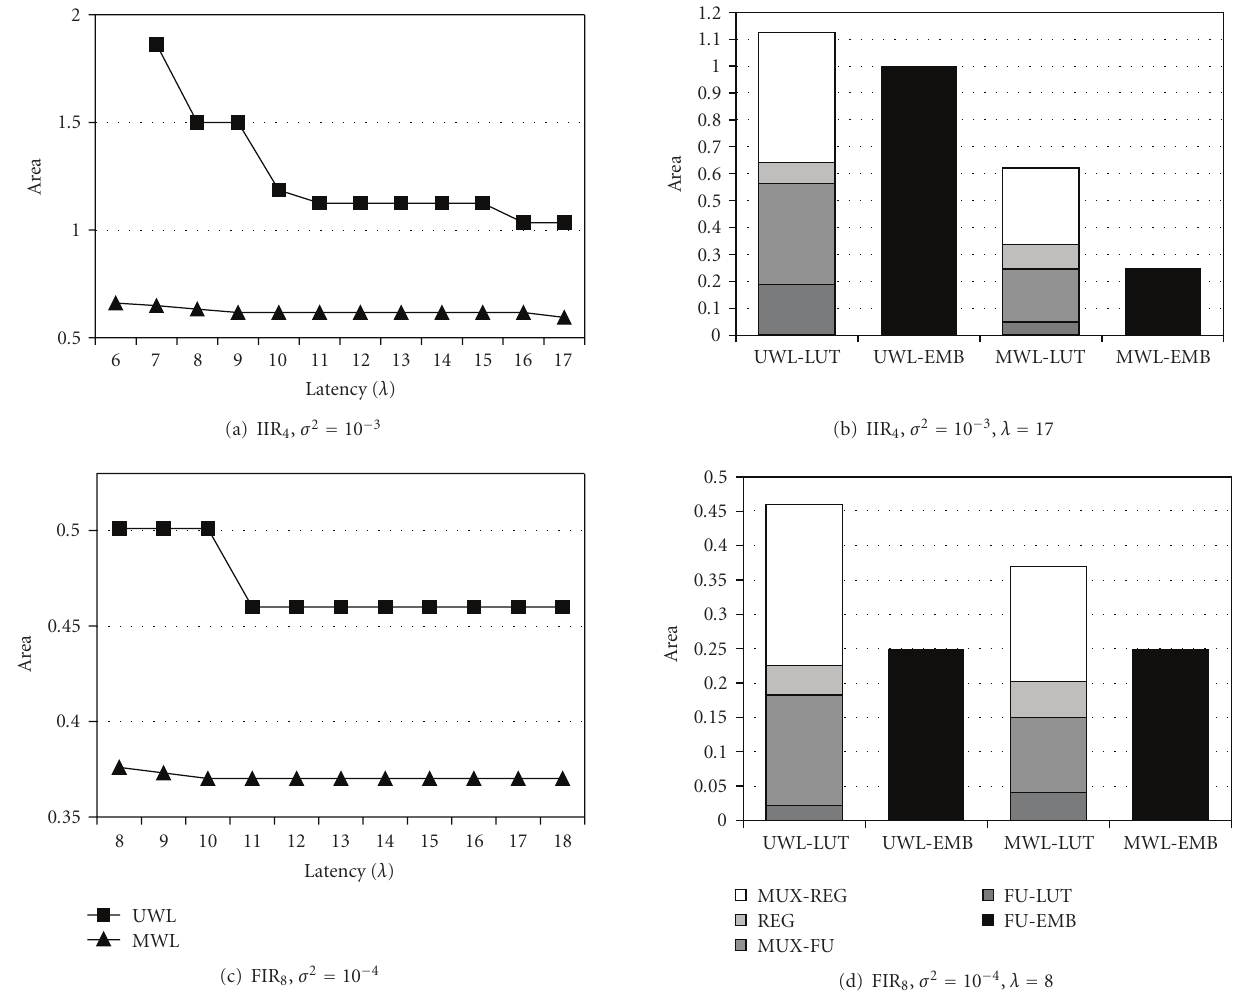
Figure 7: UWL versus MWL: homogeneous implementations